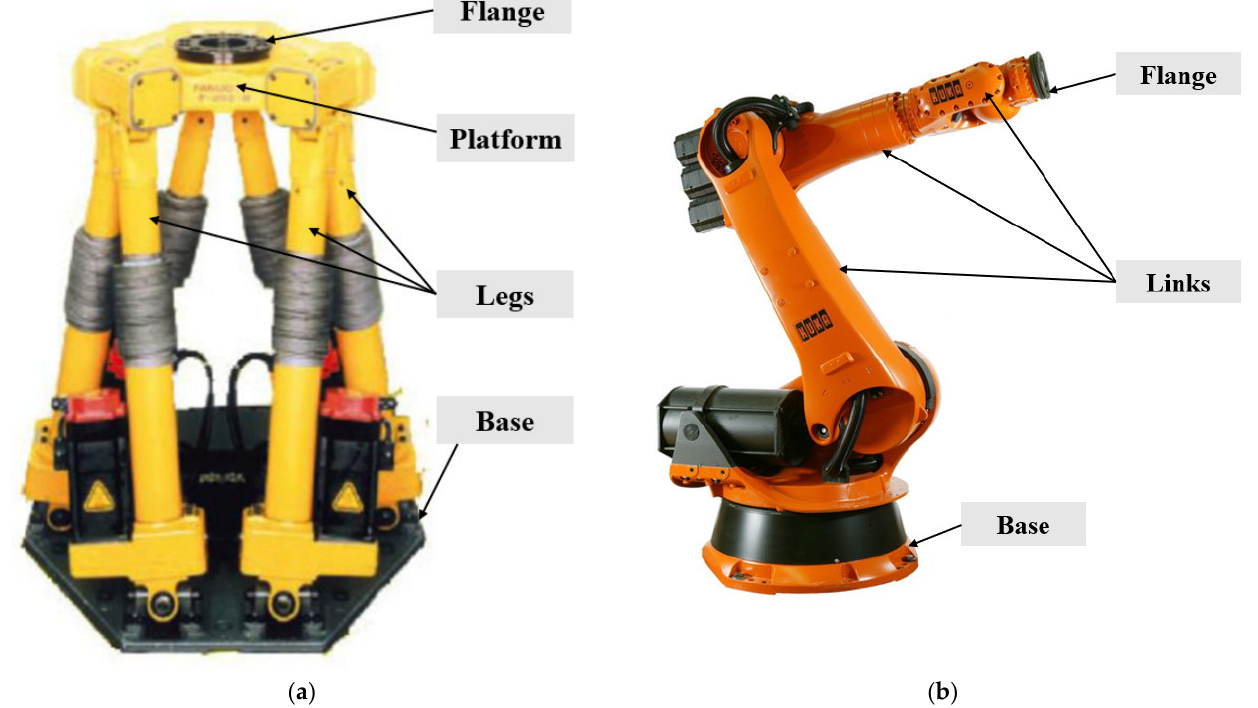
Figure 1. Two types of industrial robots for the machining process: ( a ) a hexapod parallel robot and ( b ) a KUKA si x -axis serial robot.